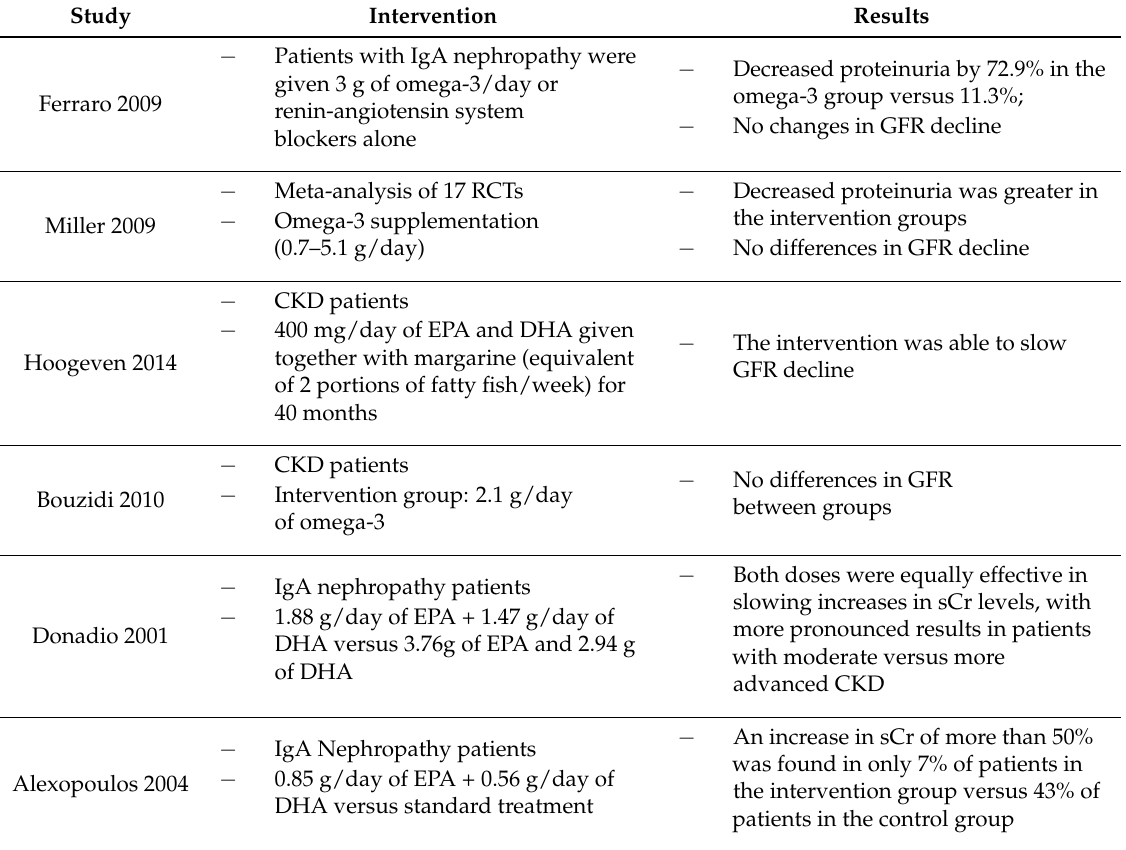
Table 2. Studies of omega-3 supplementation in